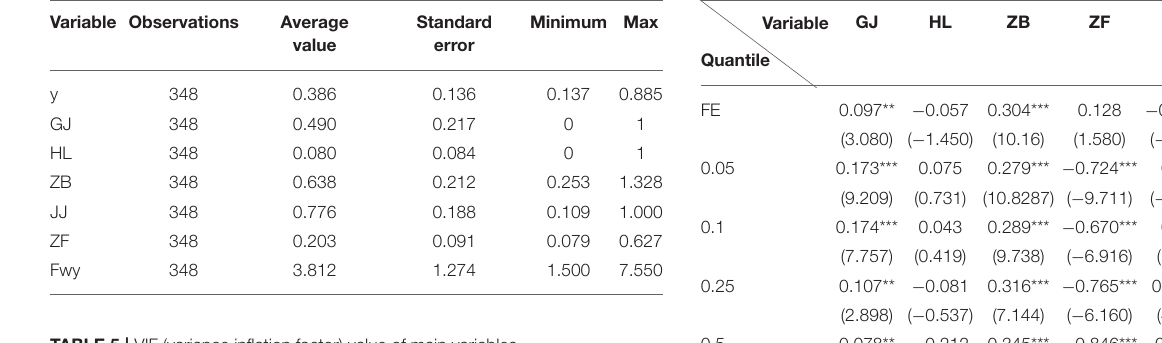
TABLE 5 | VIF (variance inflation factor) value of main variables.